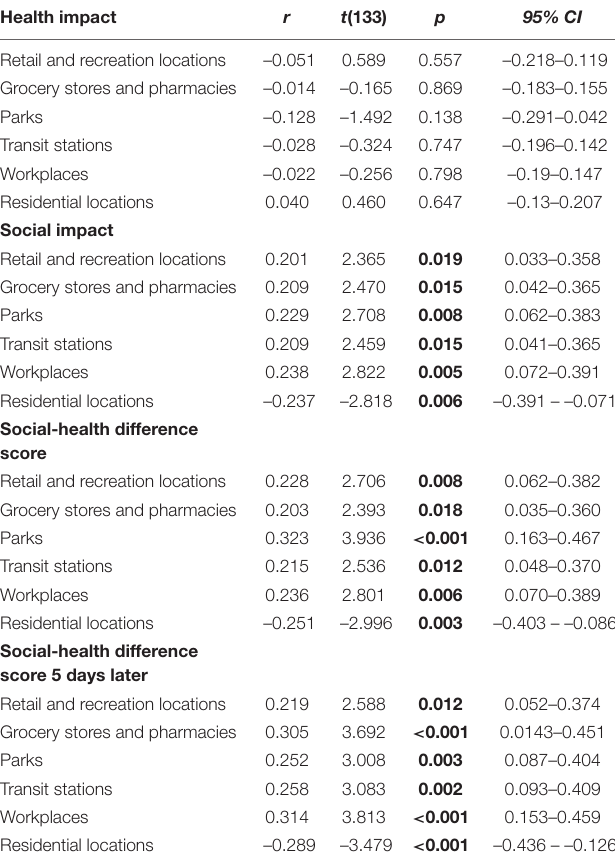
TABLE 1 | Correlations between in-sample perceptions of impact and out-of-sample state-level movement for individual locations assessed in the Google Mobility